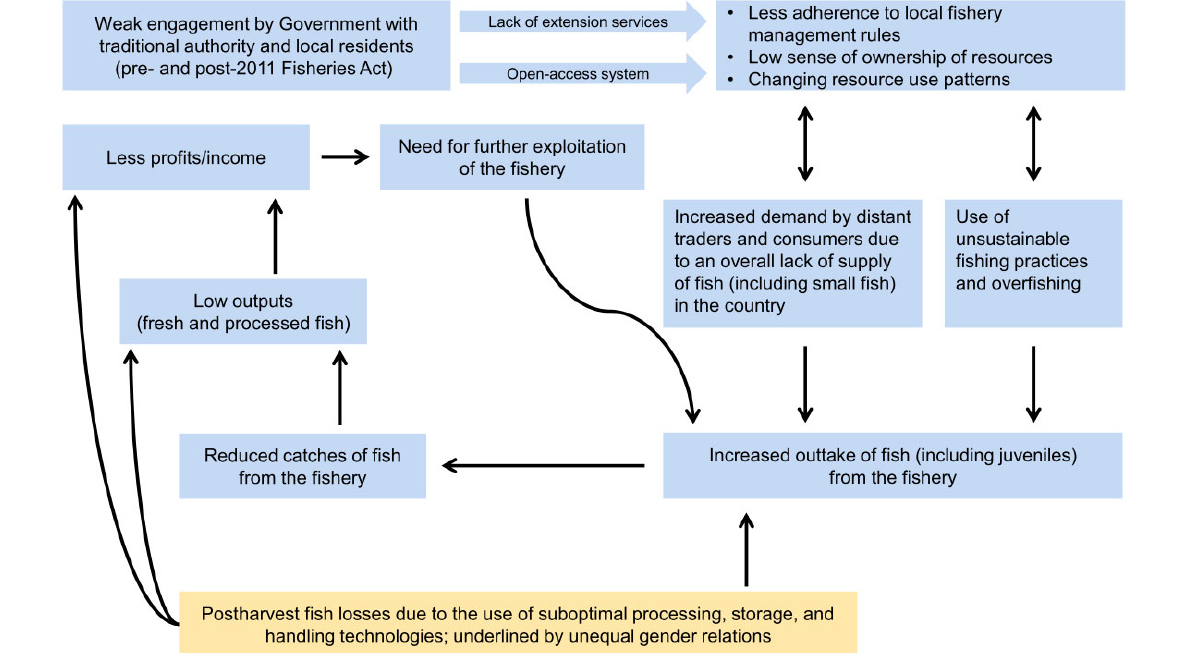
Fig. 3 . A social-ecological trap: Interactions between external drivers and social and ecological variables in the Barotse Floodplain fishery. The outcome is a feedback process that locks the system to a development path where ecosystem services decline, outputs, e.g., fish primarily harvested by men and processed by women, remain low, and value chain actors remain relatively